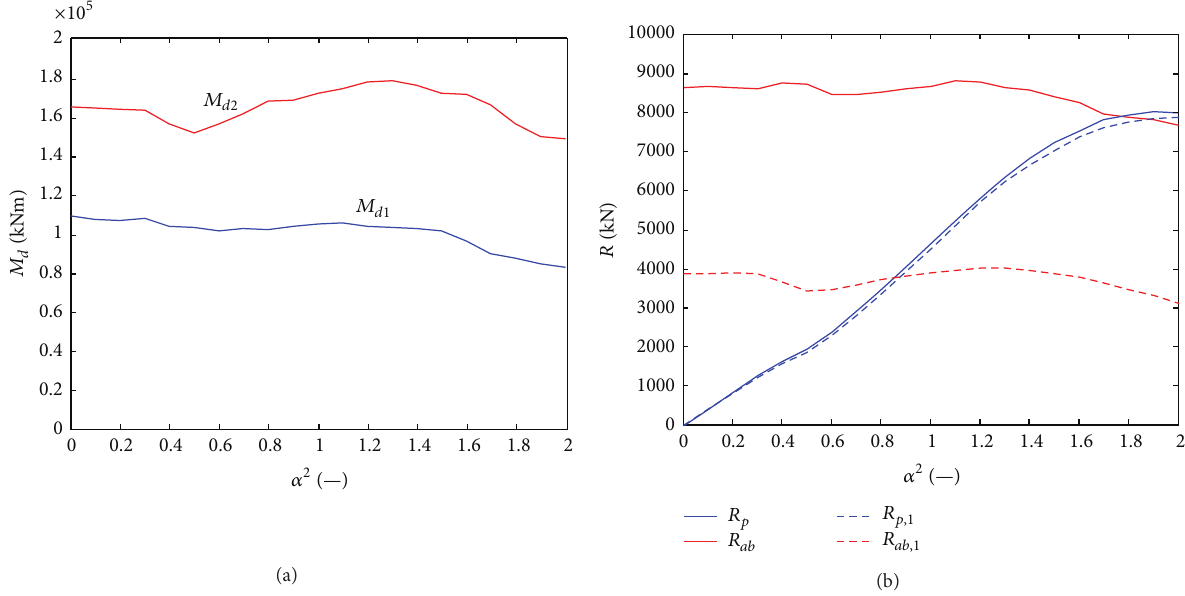
Figure 7: (a) Variation with 𝛼 2 of the peak average bending moments in correspondence with the external piers ( 𝑀 𝑑1 ) and the central pier ( 𝑀 𝑑2 ); (b) variation with 𝛼 2 of the peak average total pier reactions ( 𝑅 𝑝 ) and abutment reactions ( 𝑅 𝑎𝑏 ) and of the corresponding first mode contribution ( 𝑅 𝑝,1 , 𝑅 𝑎𝑏,1